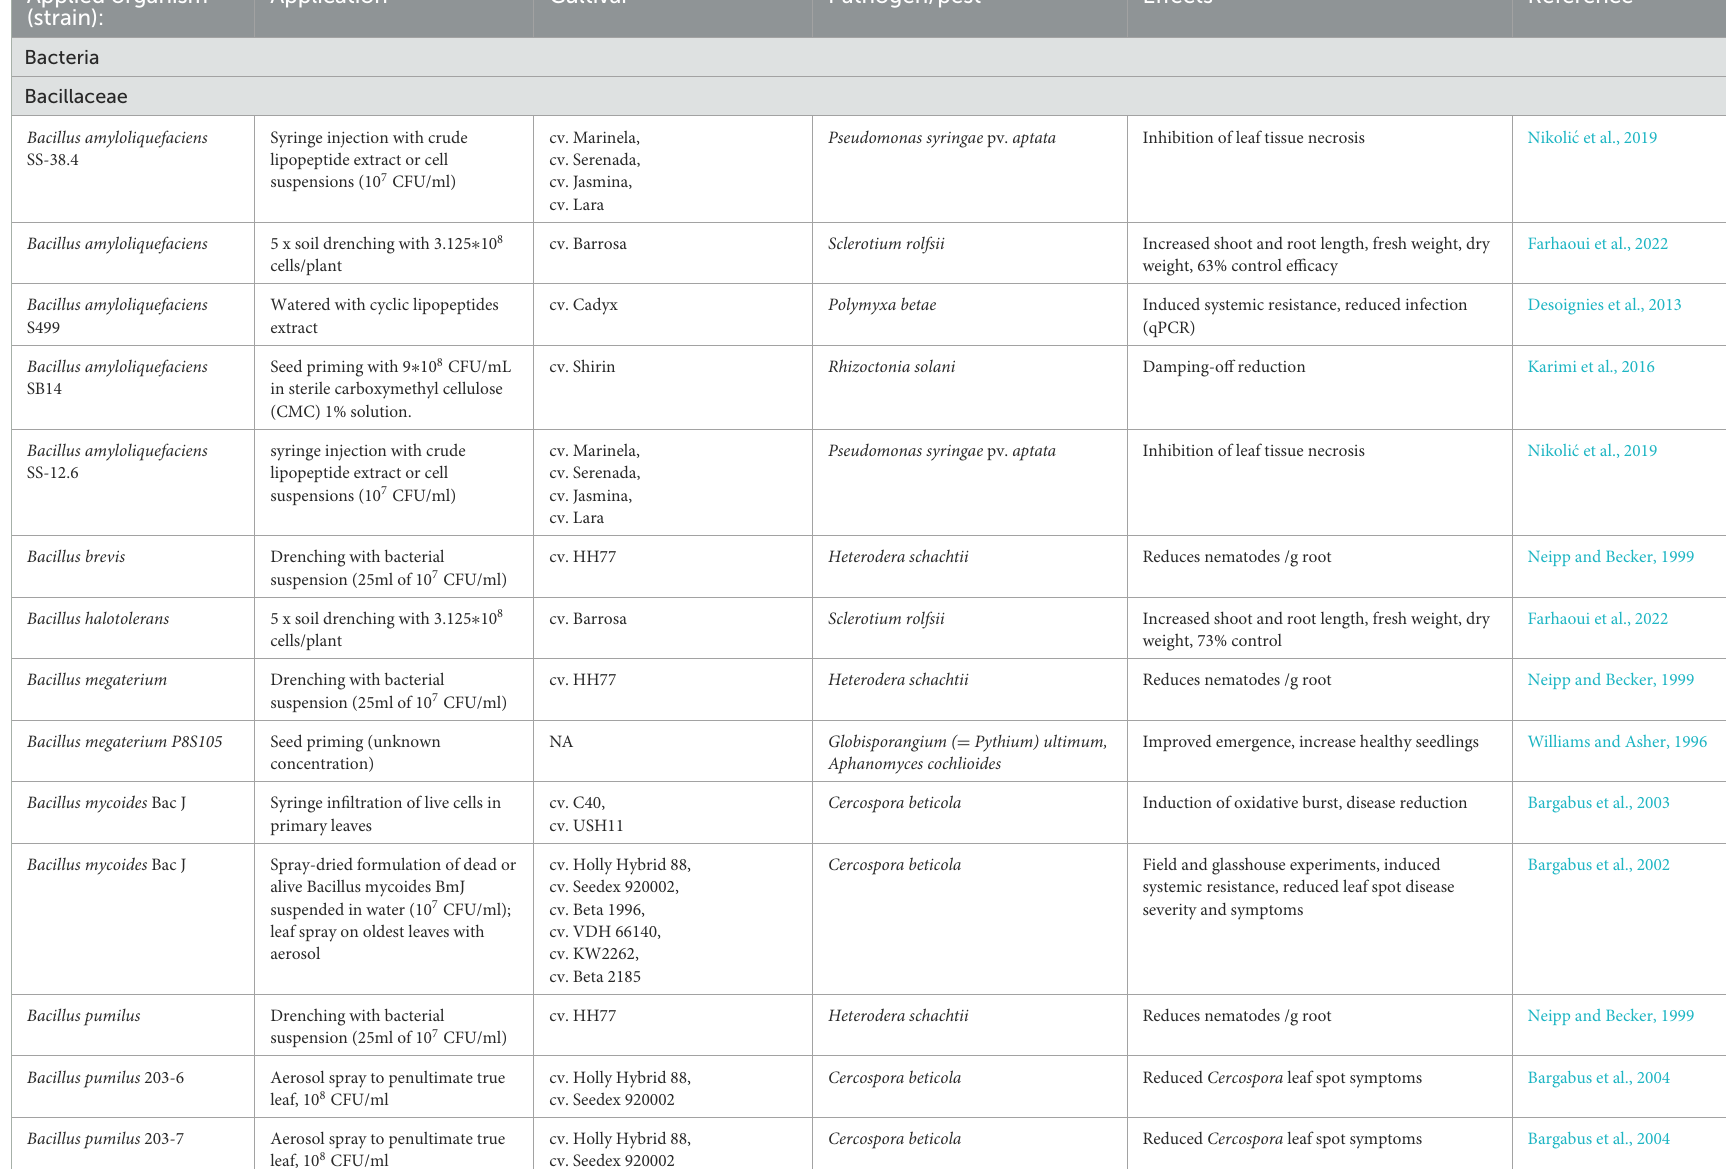
TABLE 1 Biocontrol of selected phytopathogens and plant growth promotion potential of different biocontrol agents (BCAs). Applied organism